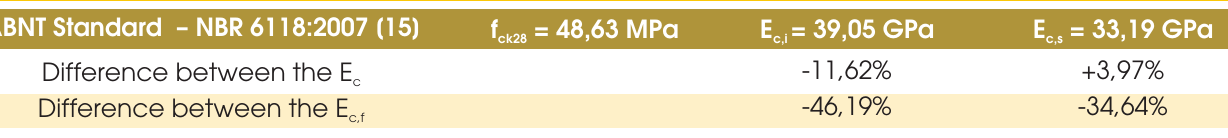
Table 5 – Initial tangent static modulus of elasticity – ABNT – NBR